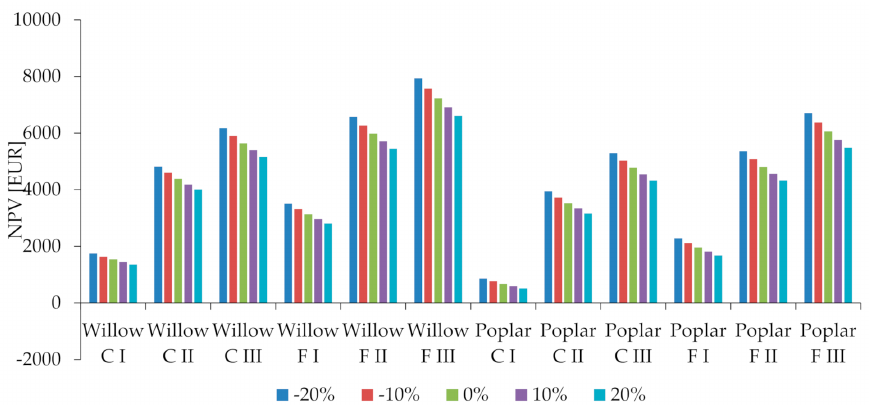
Figure 2. The effect of changes in the discounted rate on the NPV for willow and poplar chip production depending on the soil fertilisation option and payment